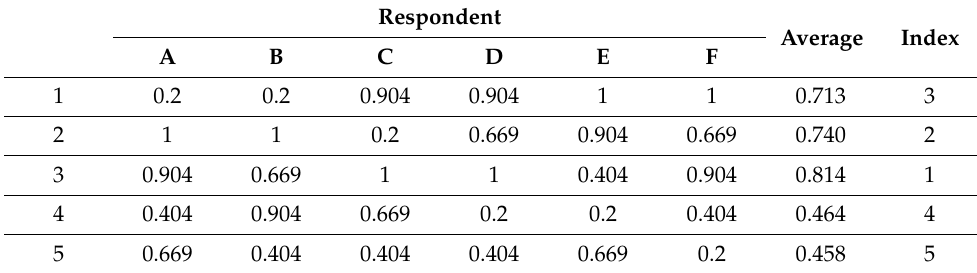
Table 5. Average weight of each